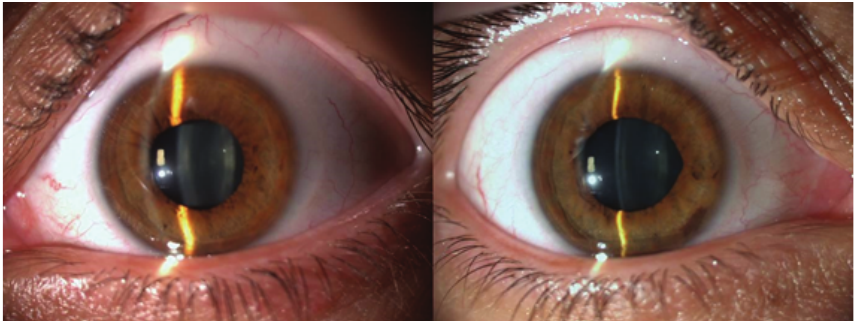
Figure 1: Bilateral iris atrophy correlated with the ablation zone and middilated pupils (due to the probable ischemic damage of the iris sphincter muscle).